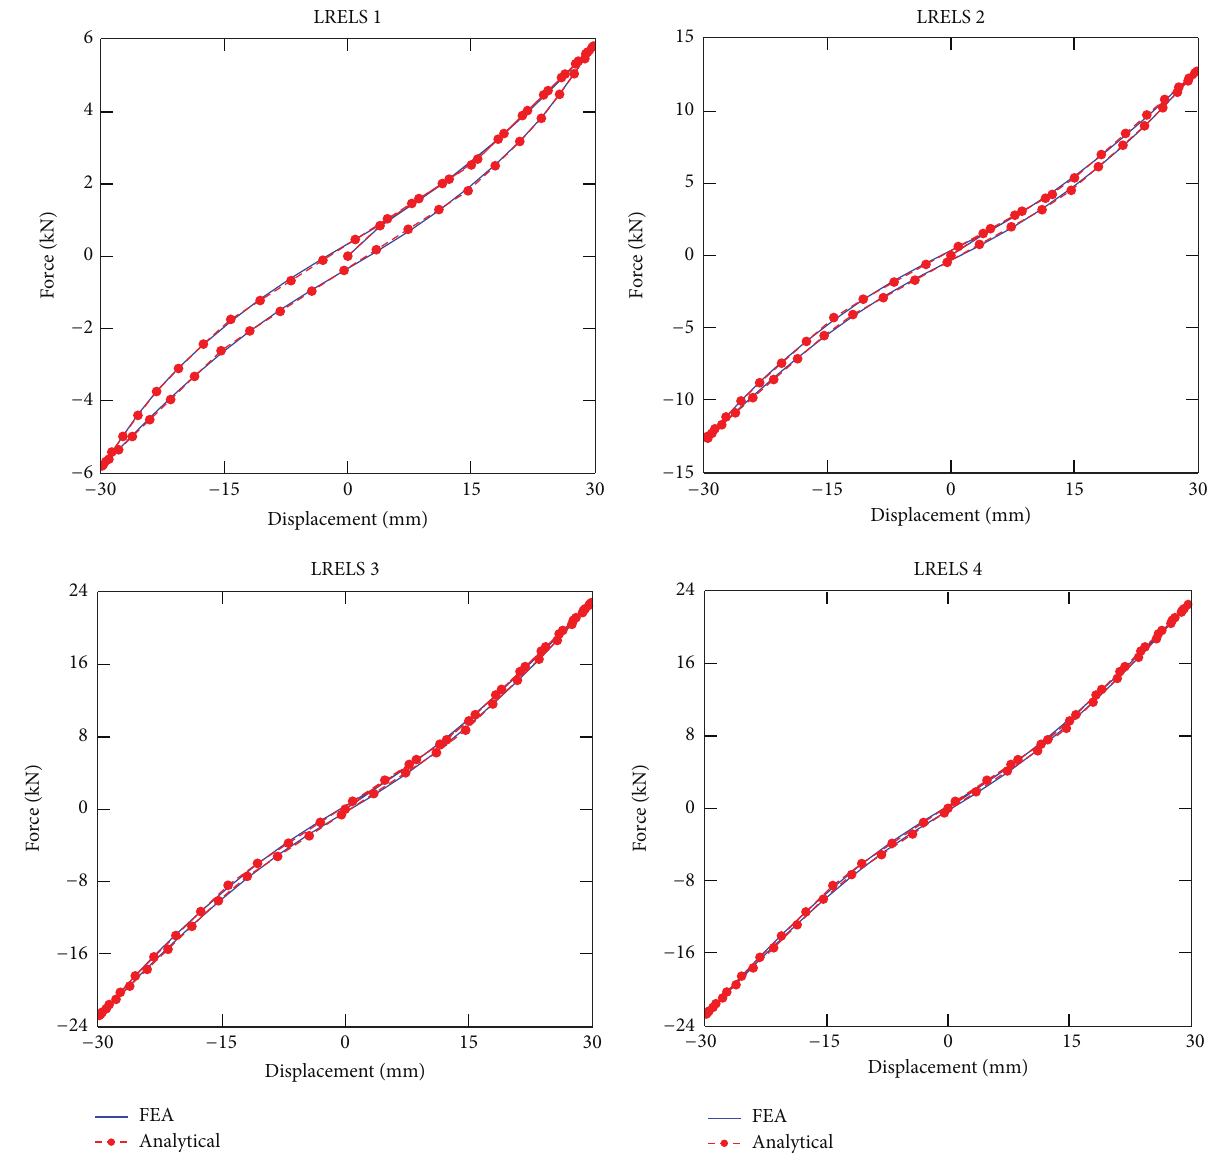
Figure 8: Out-of-plane force-displacement